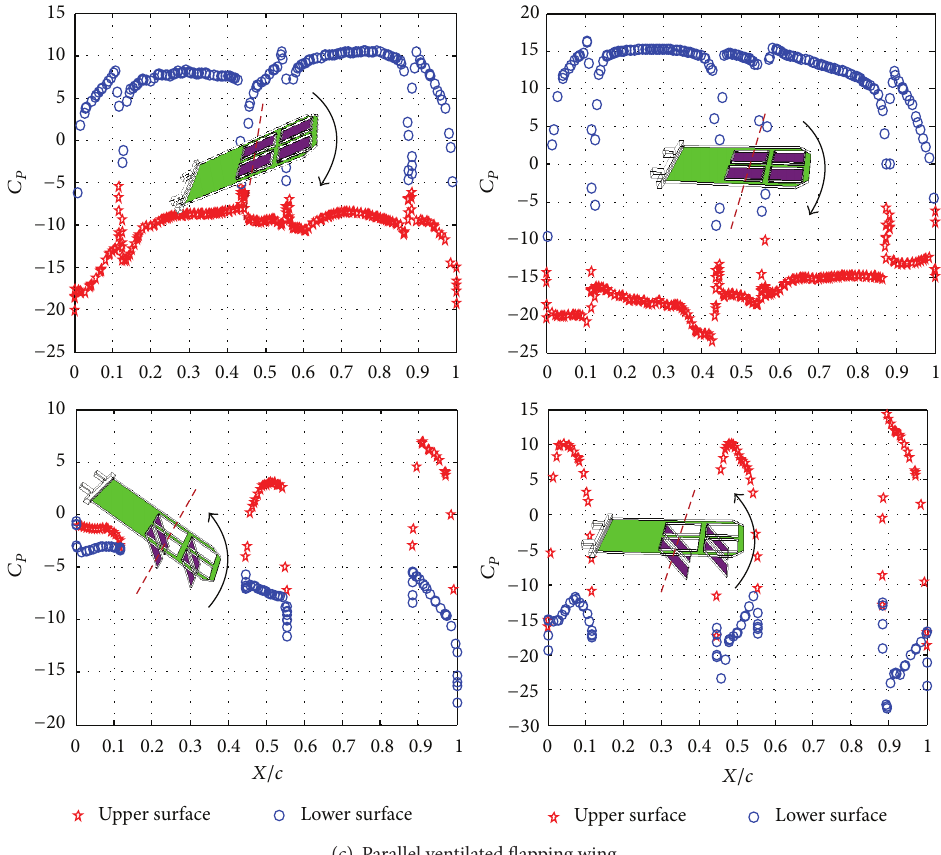
Figure 9: Pressure coefficient (𝐶 𝑃 ) at 𝑡 = 0.25 T, 0.5 T, 0.75 T, and T across the 50% chord